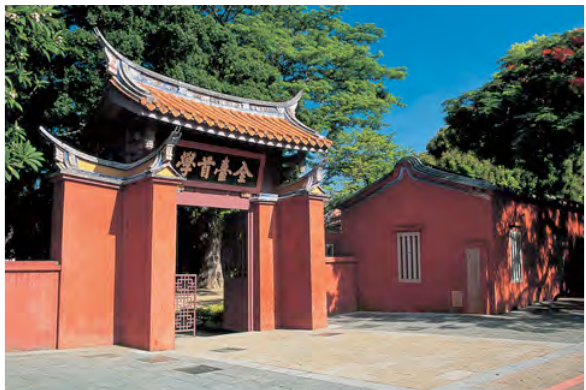
Fig. 1 Confucius Shrine in Tainan